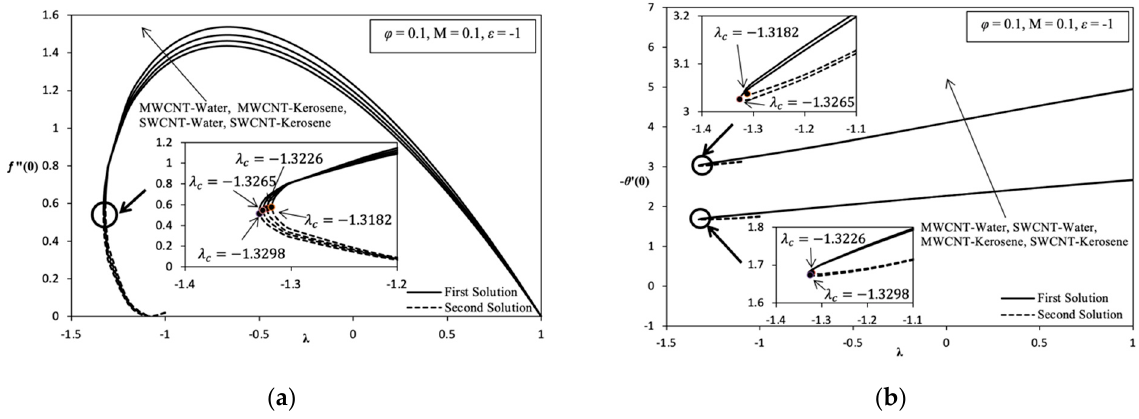
Figure 5. Variation on 𝜆 with various values of nanomaterial when 𝜑 = 0.1, M = 0.1, and 𝜀 = −1 : ( a ) Variation on f ″ (0); ( b ) Variation on − 𝜃 ′ (0).